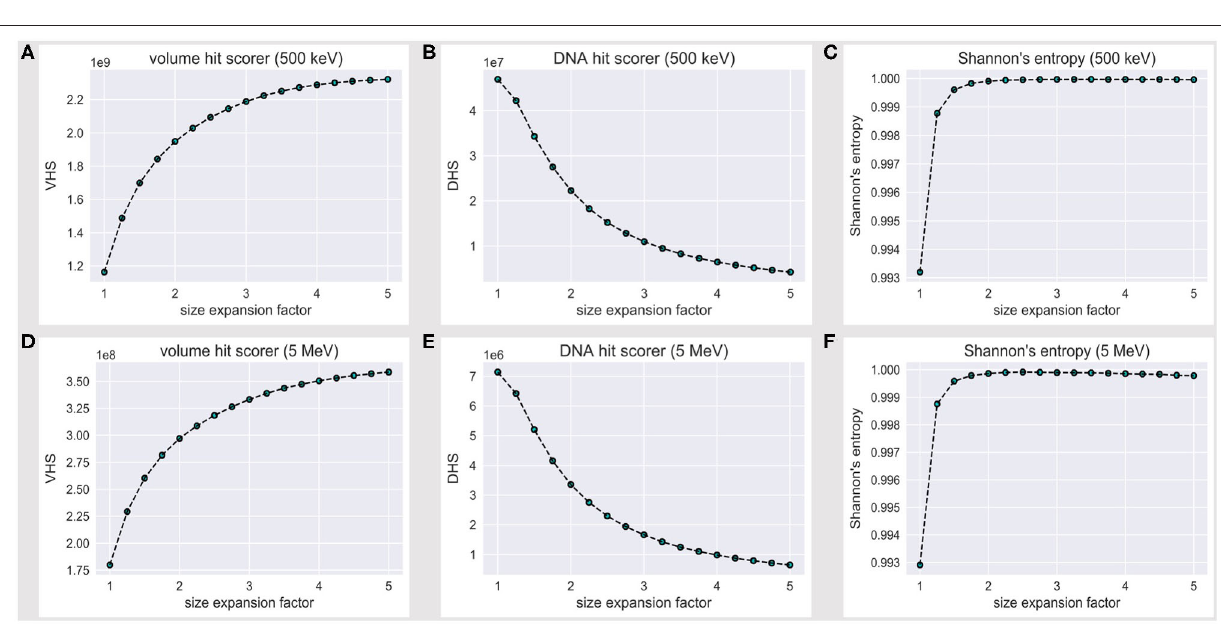
FIGURE 3 | Volume hit score (VHS) at (A) 500 keV and (D) 5 MeV; DNA hit score (DHS) at (B) 500 keV and (E) 5 MeV; the VHS increase with the expansion of the water box is associated with a decrease in the DHS. The level of flatness for the DNA hit counter is established via a normalized Shannon’s entropy formula (Eq. 1)